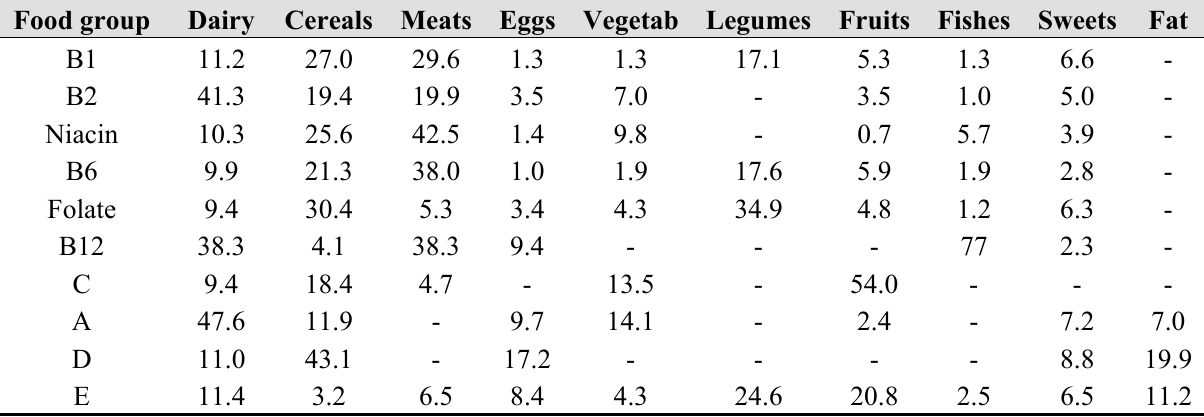
Table 6. Percentage contribution (%) of food groups to daily vitamin intake. Food group